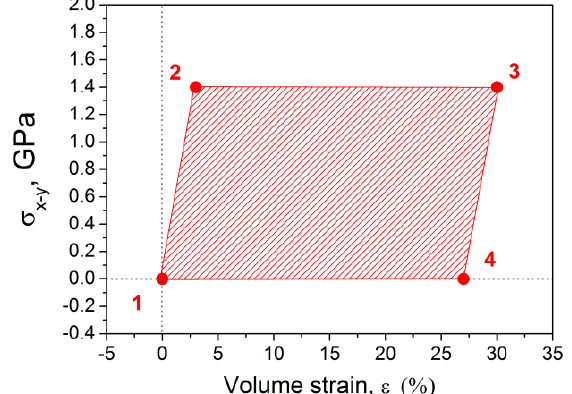
Figure 3. Stress-strain curve of the Mg/Ta/Pd thin films during (de-)hydrogenation; numbers represent different hydrogenation and dehydrogenation steps, namely